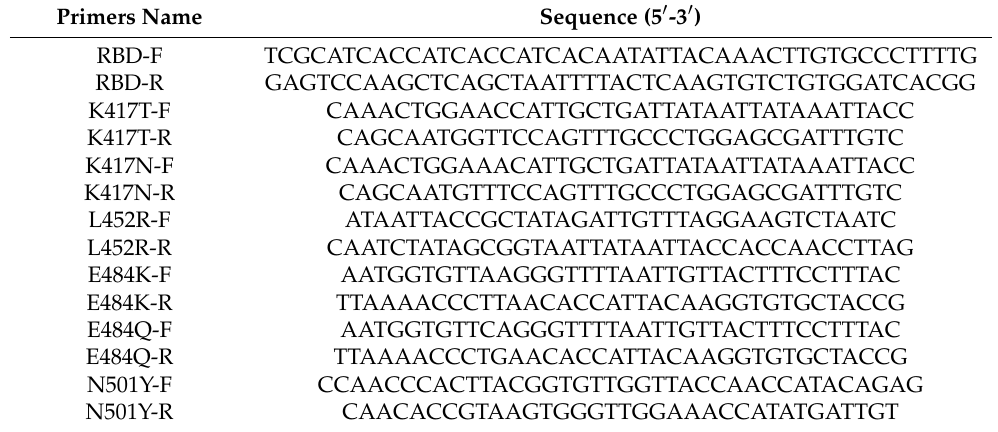
Table 1. List of primers used in this